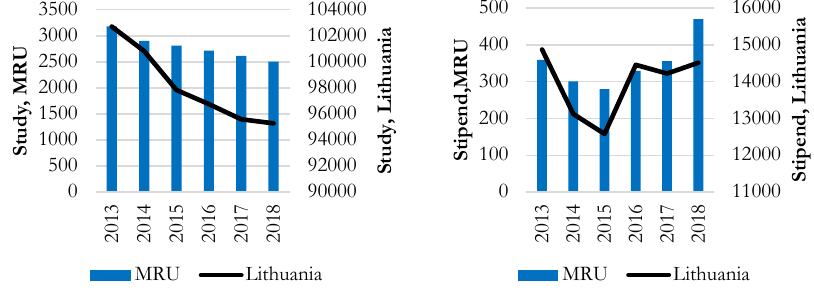
Fig. 5 – Lithuanian state budget appropriations in thousands of EUR. Source: Statistics Lithuania (2019); Mykolas Romeris University (2019)